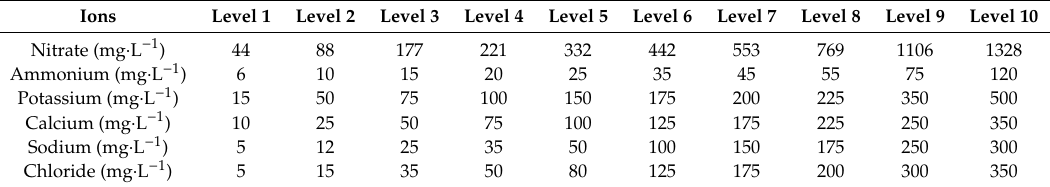
Table 2. The ranges concentration of considered ions prepared training samples.